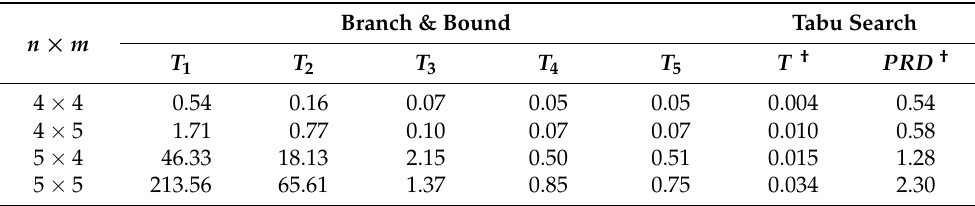
Table 3. Average running times T (in seconds) and average PRD (in percent) for instances from groups 1–5 and set A. No PRD is reported for B&B, as it is an exact method. Branch & Bound Tabu Search n × m T 1 T 2 T 3 T 4 T 5 T † PRD † 4 × 4 0.54 0.16 0.07 0.05 0.05 0.004 0.54 4 × 5 1.71 0.77 0.10 0.07 0.07 0.010 0.58 5 × 4 46.33 18.13 2.15 0.50 0.51 0.015 1.28 5 × 5 213.56 65.61 1.37 0.85 0.75 0.034